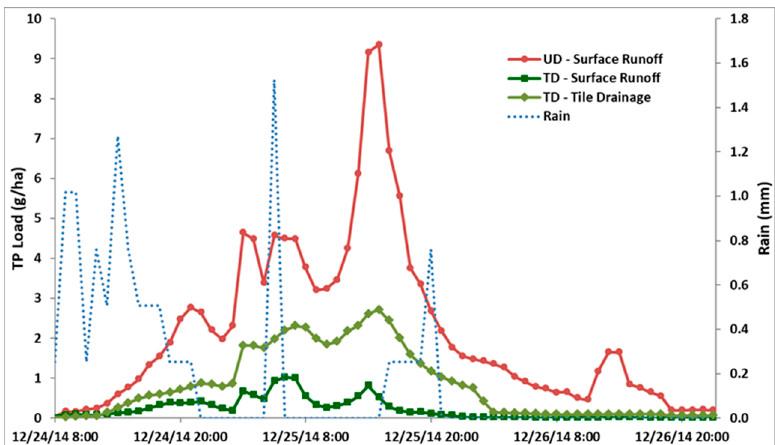
Figure 4. Total phosphorus (TP) loading by hydrologic pathway from tile-drained (TD) and undrained (UD) plots during the 24 December 2014 runoff event.